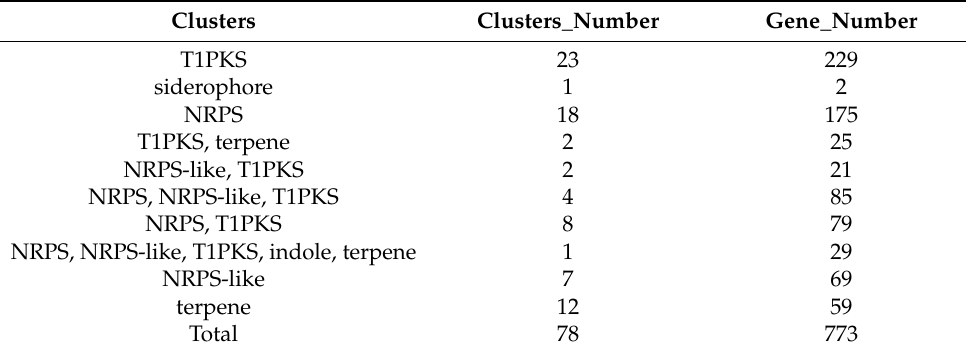
Table 5. Secondary metabolic gene cluster and gene number statistics.